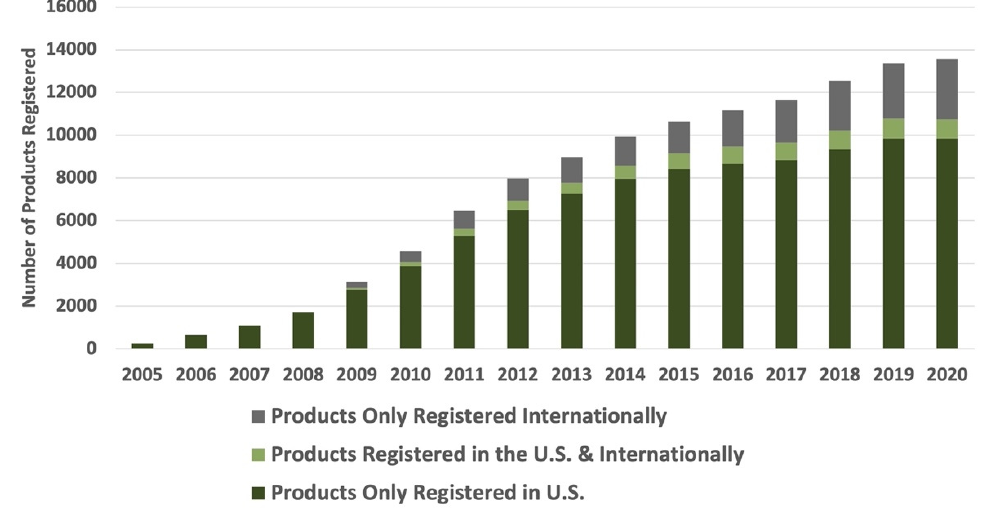
Figure 3. Whole Grain Stamp growth in the U.S. and internationally.